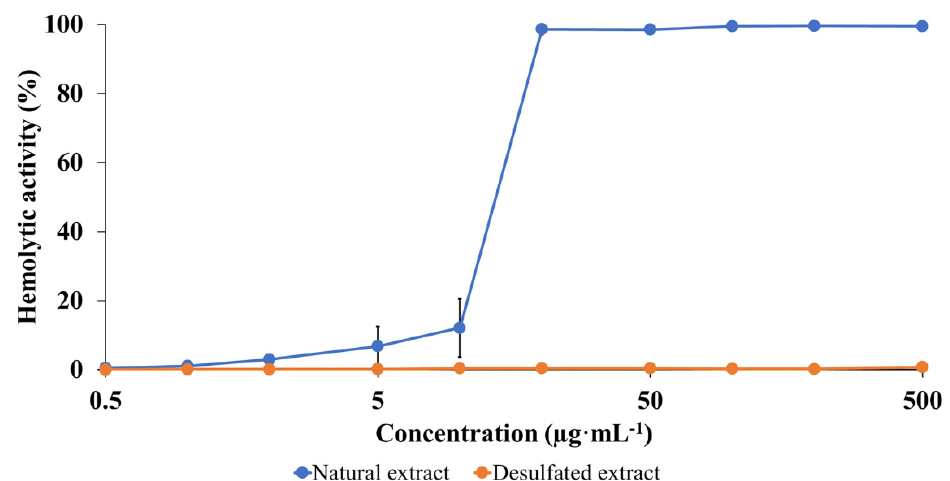
Figure 6. Evaluation of the cytotoxicity of both saponin extracts: comparison between the hemolytic activity of the natural (sulfated) saponins and of the microwave-desulfated saponins. The experiment was performed in triplicates using a 2% suspension of erythrocytes from bovine blood. The HAs are expressed in % of the HE of a reference extract constituted by 500 µ g · mL − 1 of HC saponins (see experimental).